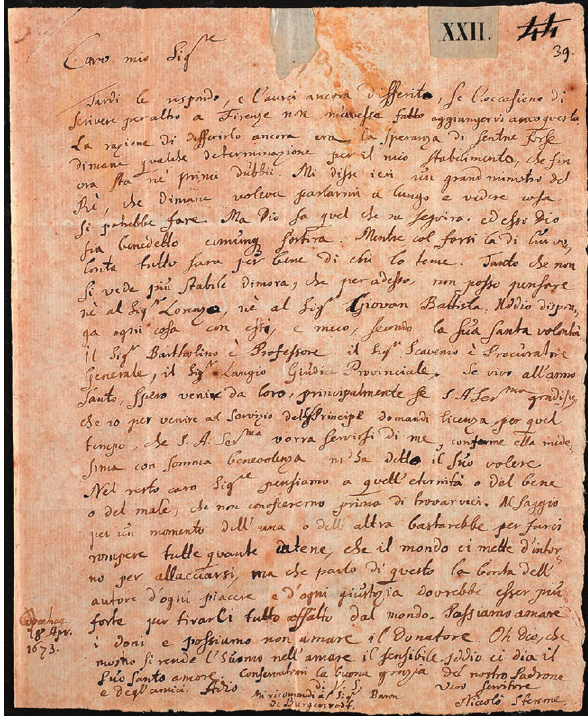
Figure 8. Steno’s letter to Vincenzo Viviani, Shelf Mark: Acc. 2019/11 Royal Danish Library, the Manuscript